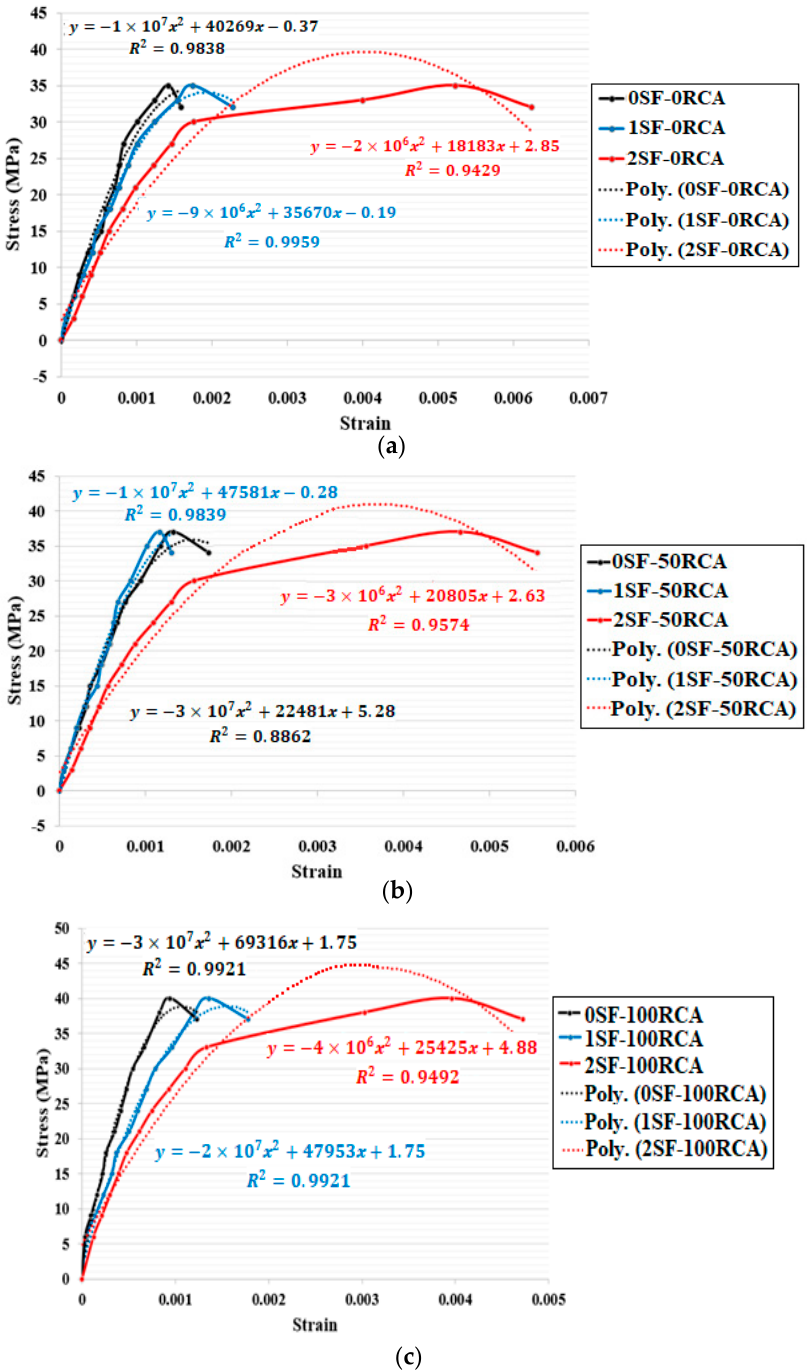
Figure 13. Stress–strain curves of the specimens ( a ) with no RCA, ( b ) 50% RCA and ( c ) 100% RCA.